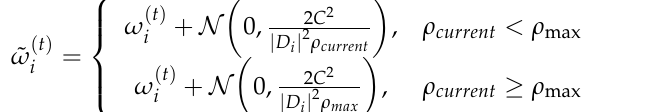
Algorithm 1 outlines ADPML with a dynamic privacy budget allocating